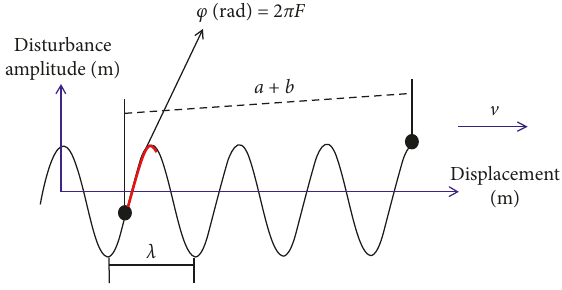
Figure 4: Disturbance inputs Z rf and Z rr . Phase angle φ is not zero.